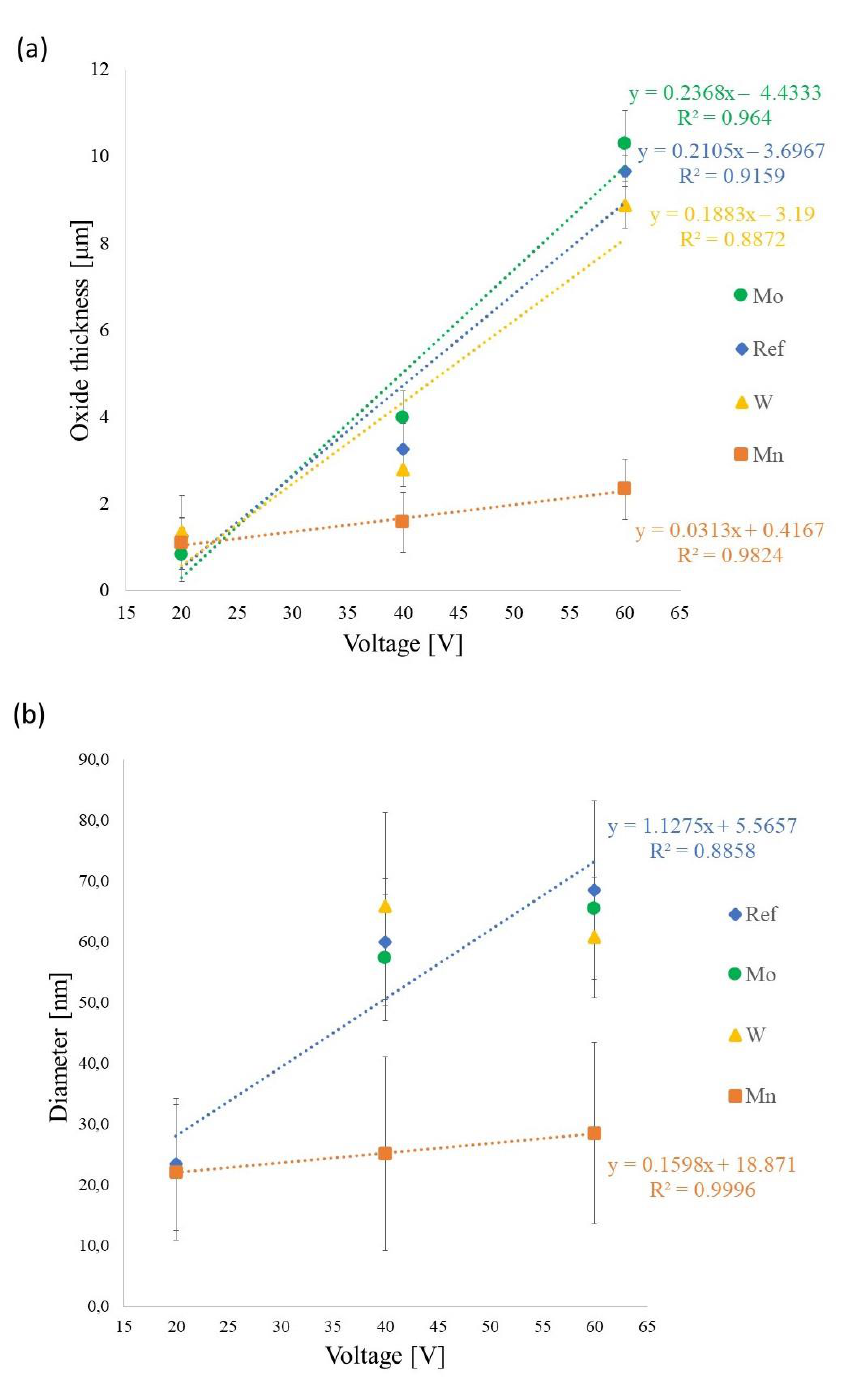
Figure 3. Thickness of anodic titanium oxide ( a ) and nanotube diameter ( b ) depending on the applied voltage and electrolyte.